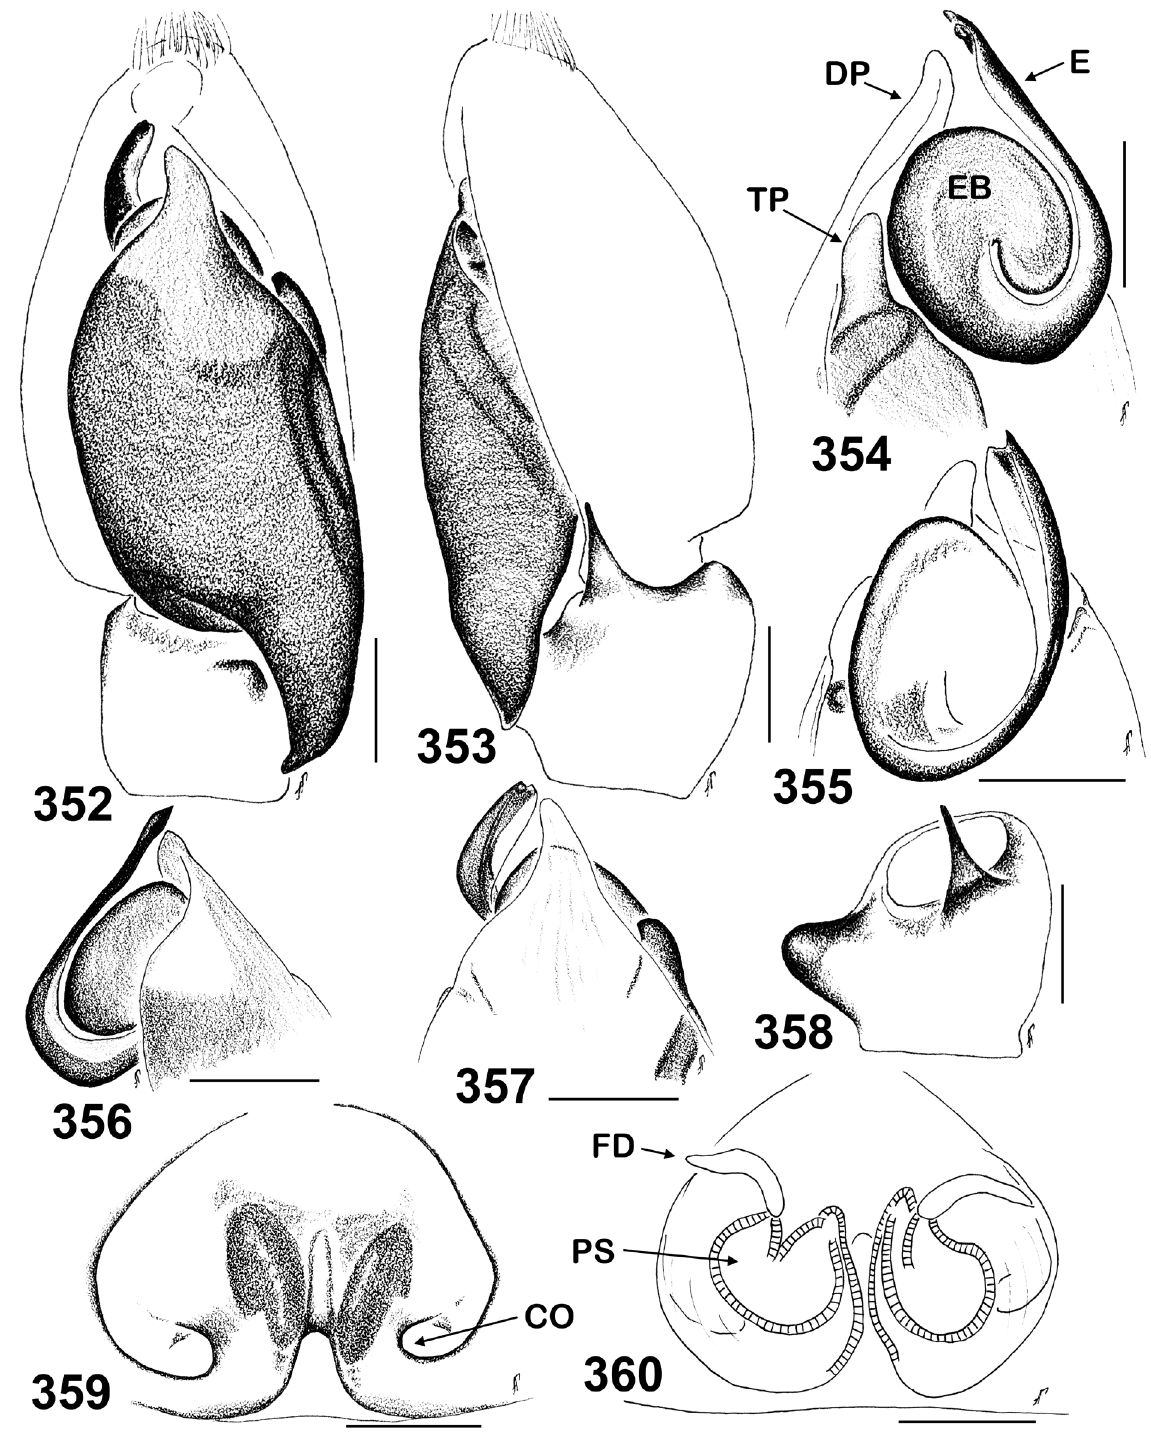
Figs 352–360. Stenaelurillus modestus Wesołowska, 2014, from South Africa (uMkhuze GR) . 352 . Male palp, ventral view. 353 . Male palp, retrolateral view. 354–357 . Embolic division. 354 . Retrolateral view. 355 . Dorsal view. 356 . Median view. 357 . Ventral view. 358 . VTA and RTA, retrolateral view. 359 . Epigyne, ventral view. 360 . Spermathecae, dorsal view. Abbreviations: see Material and methods. Scale bars: 0.1